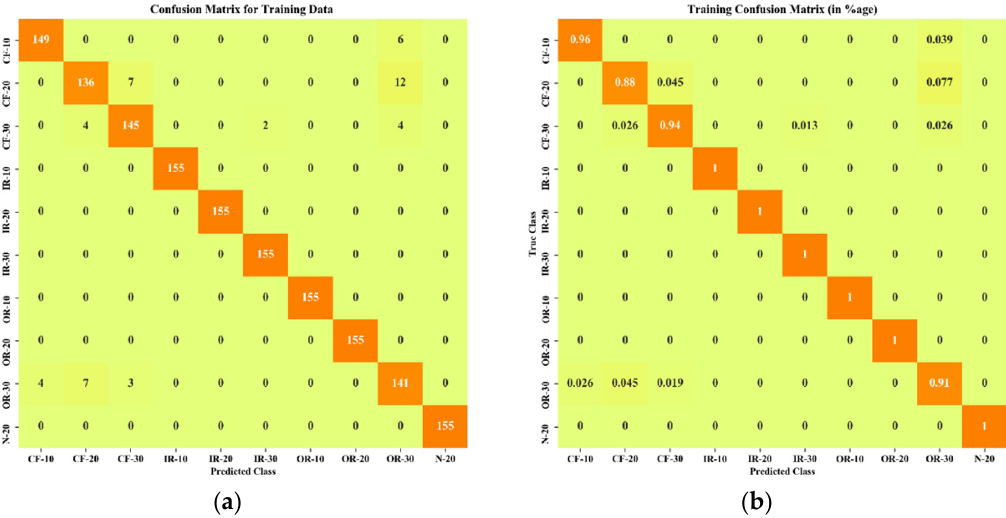
Figure 9. Confusion matrix of training data: ( a ) in terms of number of training data points; ( b ) in terms of percentage (%).